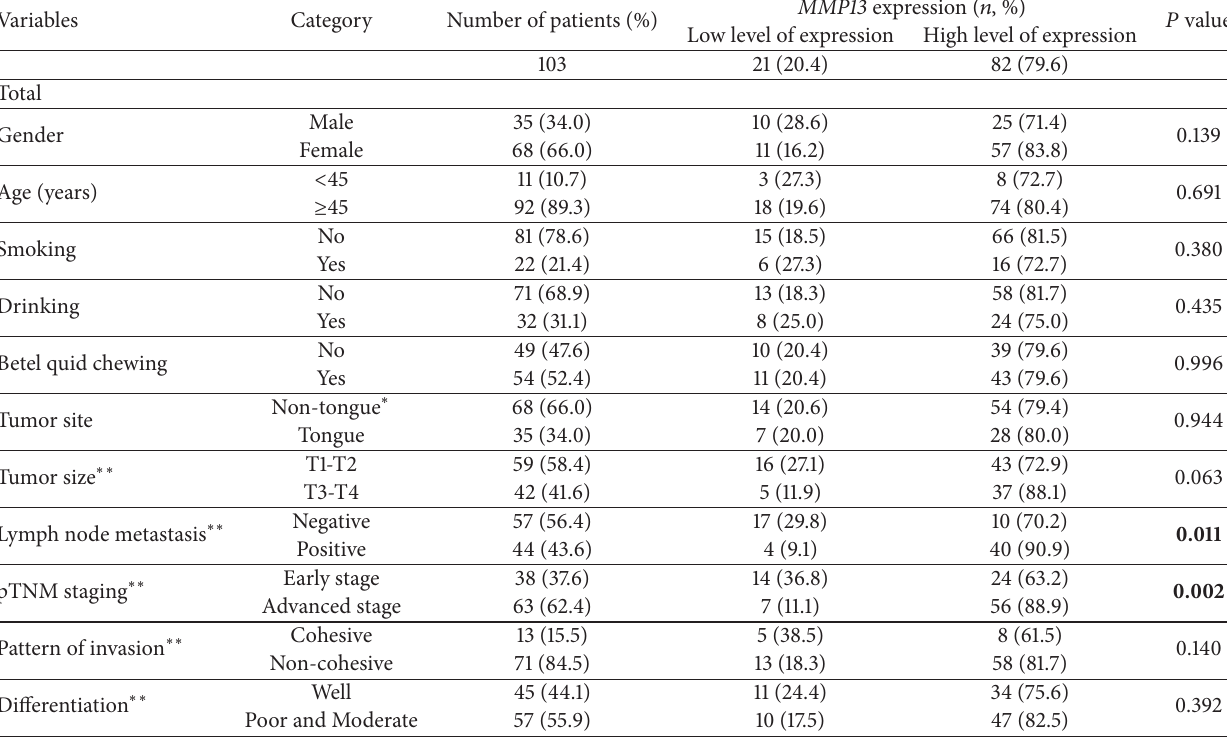
Table 2: Association of MMP13 protein expression with clinicopathological parameters.